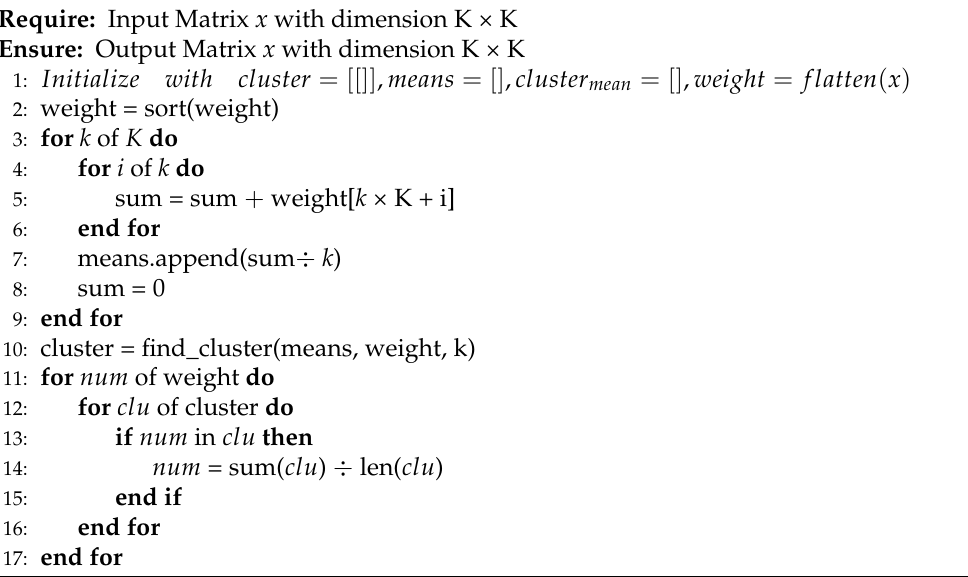
Algorithm 1 Simon k -means For Convolutional